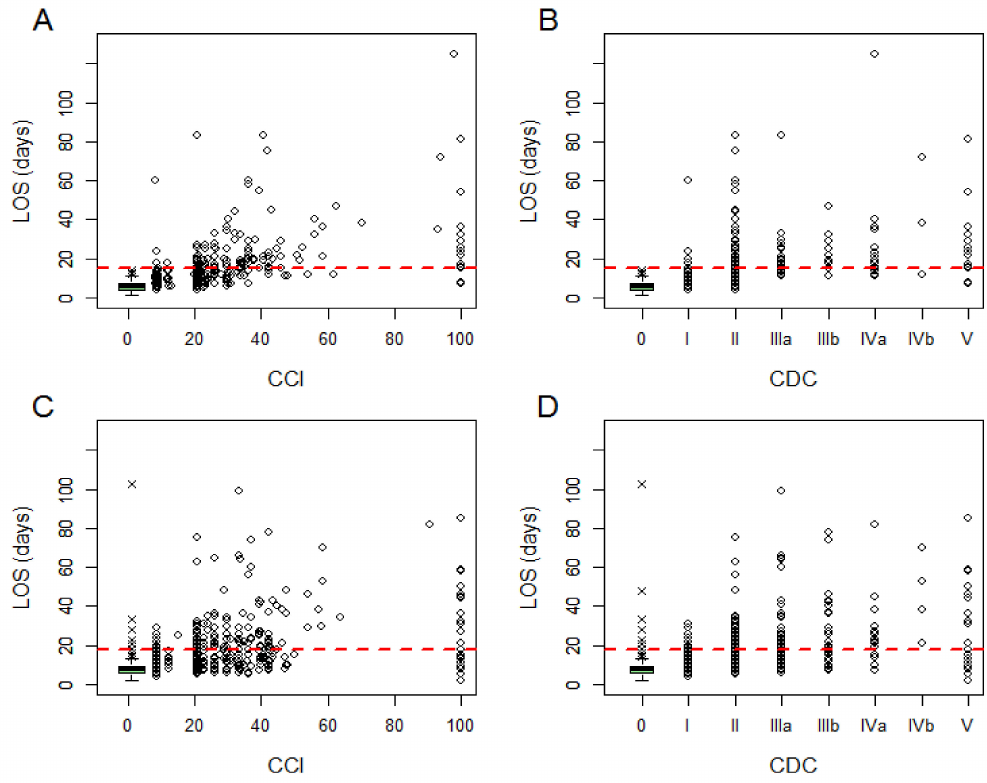
Figure 2. Scatter plots of the distribution of length of hospital stay (LOS). ( A ) Comprehensive complication index (CCI) in the derivation set. ( B ) Clavien-Dindo classification (CDC) in the derivation set; ( C ) comprehensive complication index (CCI) in the validation set; ( D ) Clavien-Dindo classification (CDC) in the validation set. The distribution of LOS for patients with CCI and CDC = 0 is represented with a boxplot rather than with raw dots. The dashed red line represents the e-LOS = 15 days (75th percentile of LOS among patients with at least one complication in the derivation set). Points that lie above the horizontal red line represent patients with e-LOS. Table 2. Linear regression analysis for LOS (log-transformed). The univariate models include CCI or Clavien-Dindo as the only covariate. The multivariate models are adjusted for the following covariates: type of surgery (major vs. minor), open vs. laparoscopy, age (per year), American Society of Anesthesiologists (ASA) score (1–2 vs. 3–4), Child grade (A vs. B), duration of surgery ( > 4 h vs. ≤ 4 h), center volume (high vs. medium / low). Patients died during hospital stay are excluded from all samples.